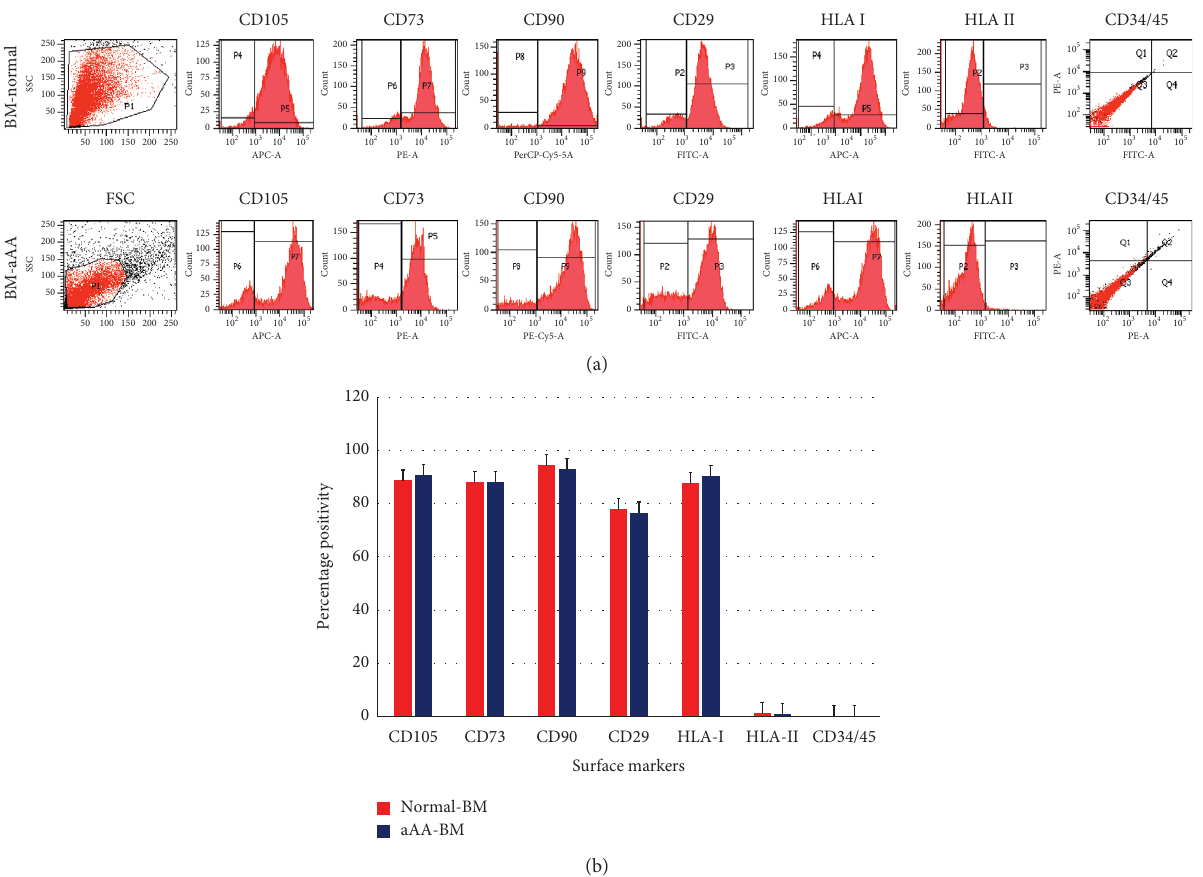
Figure 2: Immunophenotypic analysis of mesenchymal stem cells from BM-aAA and BM-normal. (a) Representative histograms for a panel of surface marker profiling. (b) A cumulative graph comparing the surface marker expression in normal MSCs and MSCs from aplastic